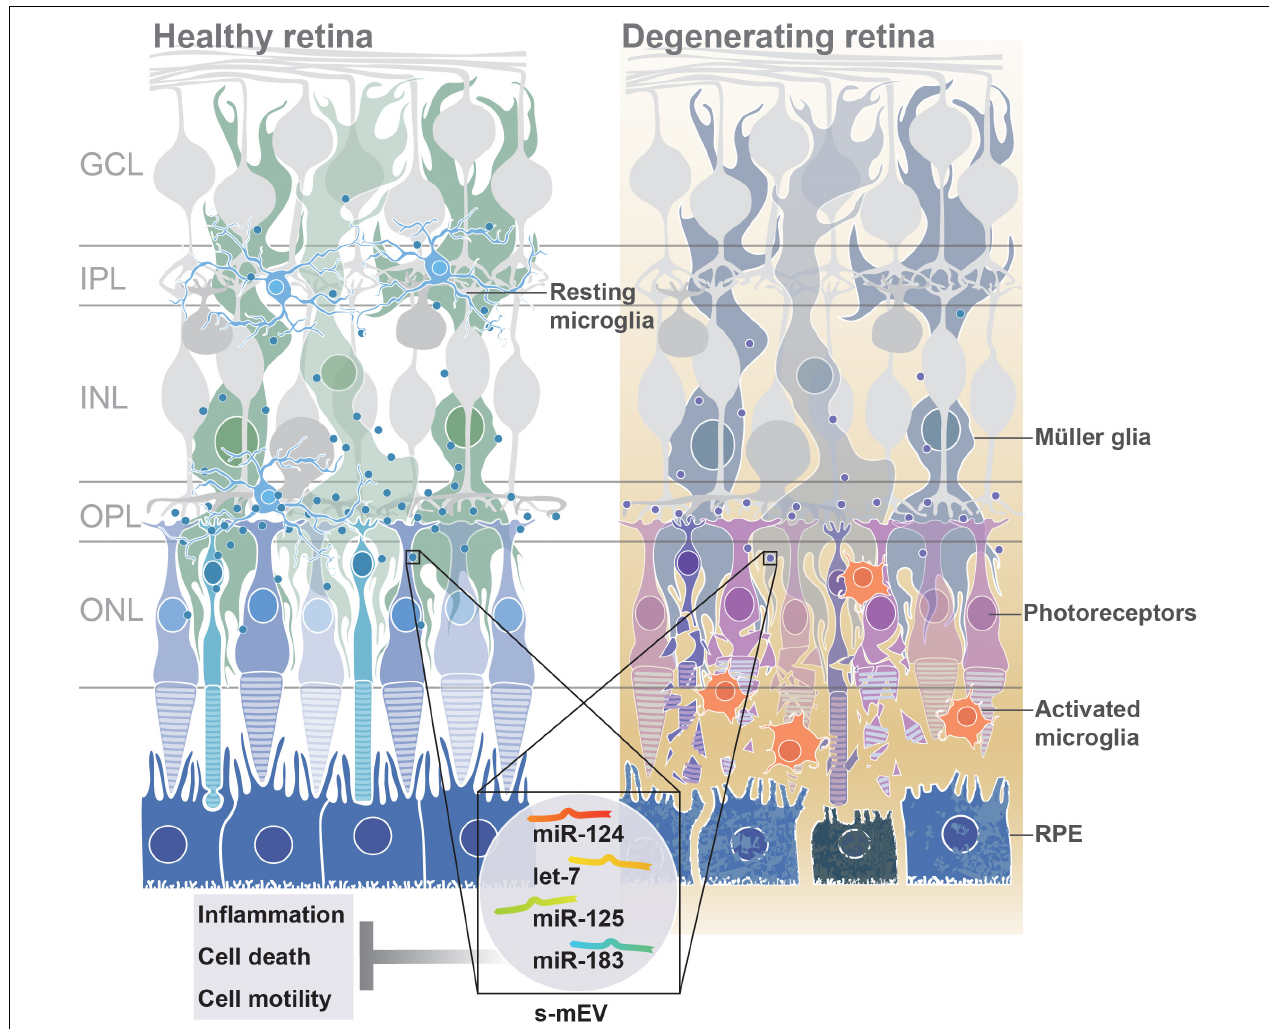
FIGURE 10 | Proposed functional role of s-mEV. Under normal homeostatic conditions, s-mEV laden with miRNA, including miR-124, let-7, miR-125, and miR-183, potentially originating from photoreceptors, are continuously trafficked between retinal neurons and glial cells. However, in retinal degenerations, a loss of photoreceptors leads to a decrease in s-mEV bioavailability, and consequently an insufficient transfer of s-mEV miRNA cargo to their cell targets. As the retinal targetome of s-mEV-miRNAs is associated with inflammation, survival and cell motility pathways, inadequate pathway regulation following s-mEV depletion leads to exacerbated retinal